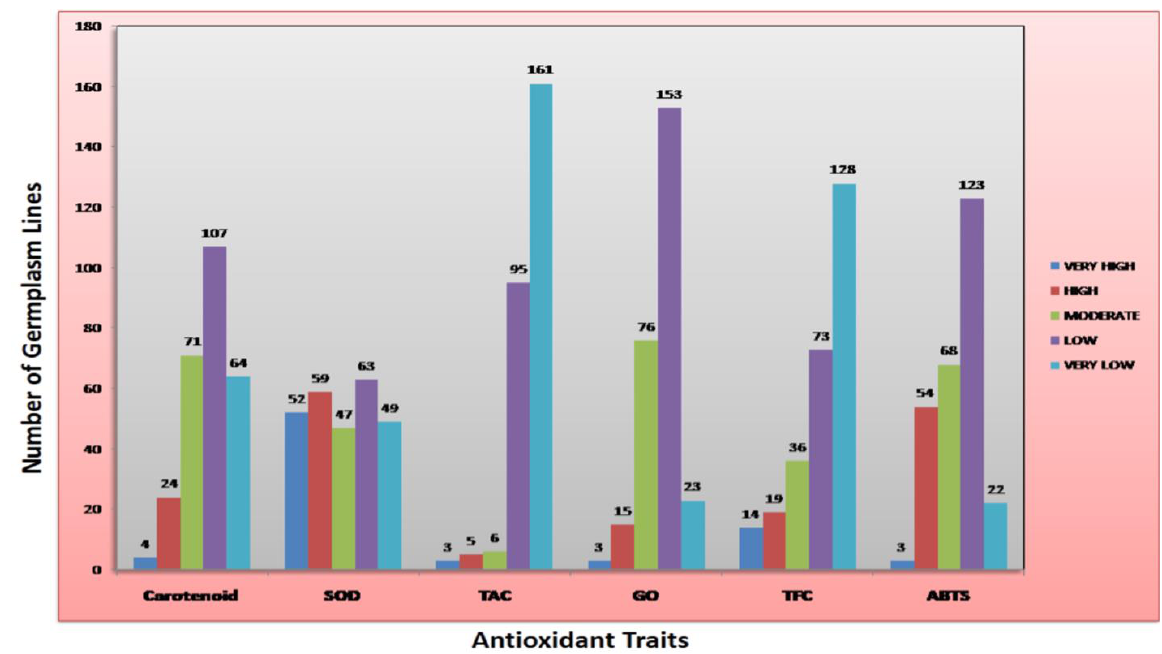
Figure 1. Frequency distribution of germplasm lines for each of the studied antioxidant traits, namely, carotenoids, superoxide dismutase, anthocyanins, γ -oryzanol, flavonoids, and ABTS present in the shortlisted 270 germplasm lines.